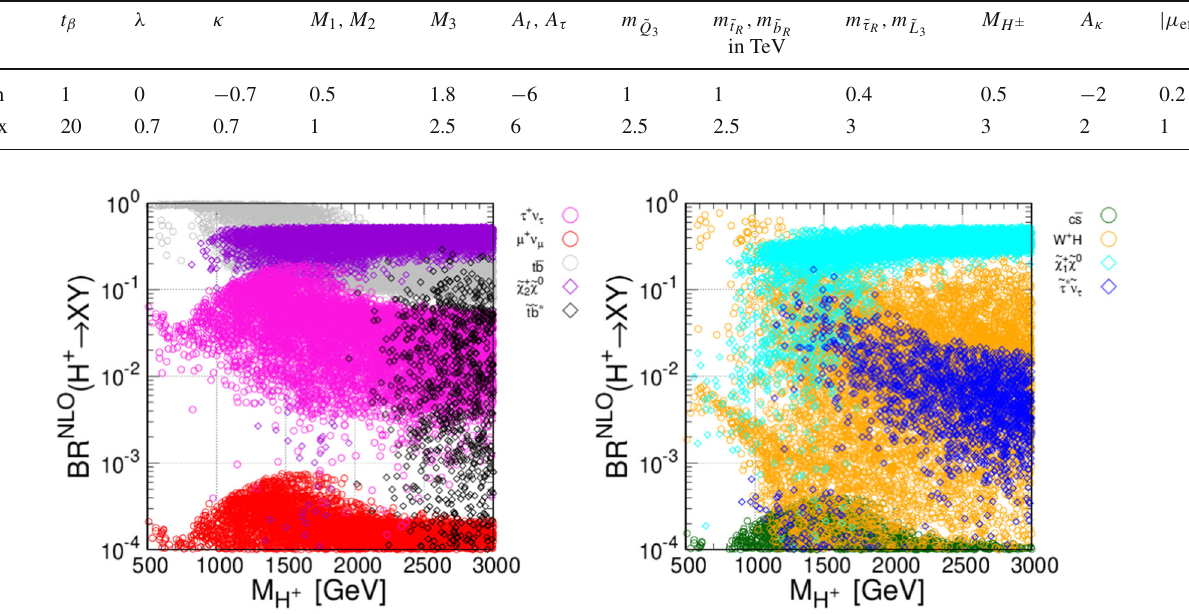
˜ χ 0 (violet diamond), τ + ν τ (pink circle), Left: t ¯ b (gray diamond), ˜ χ + 2 + H (orange circle) ˜ t ˜ b ∗ (black diamond), μ + ν μ (red circle); right: W ˜ χ + ˜ χ 0 (cyan diamond), ˜ τ ∗ ˜ ν τ (blue diamond), c ¯ s (green 1